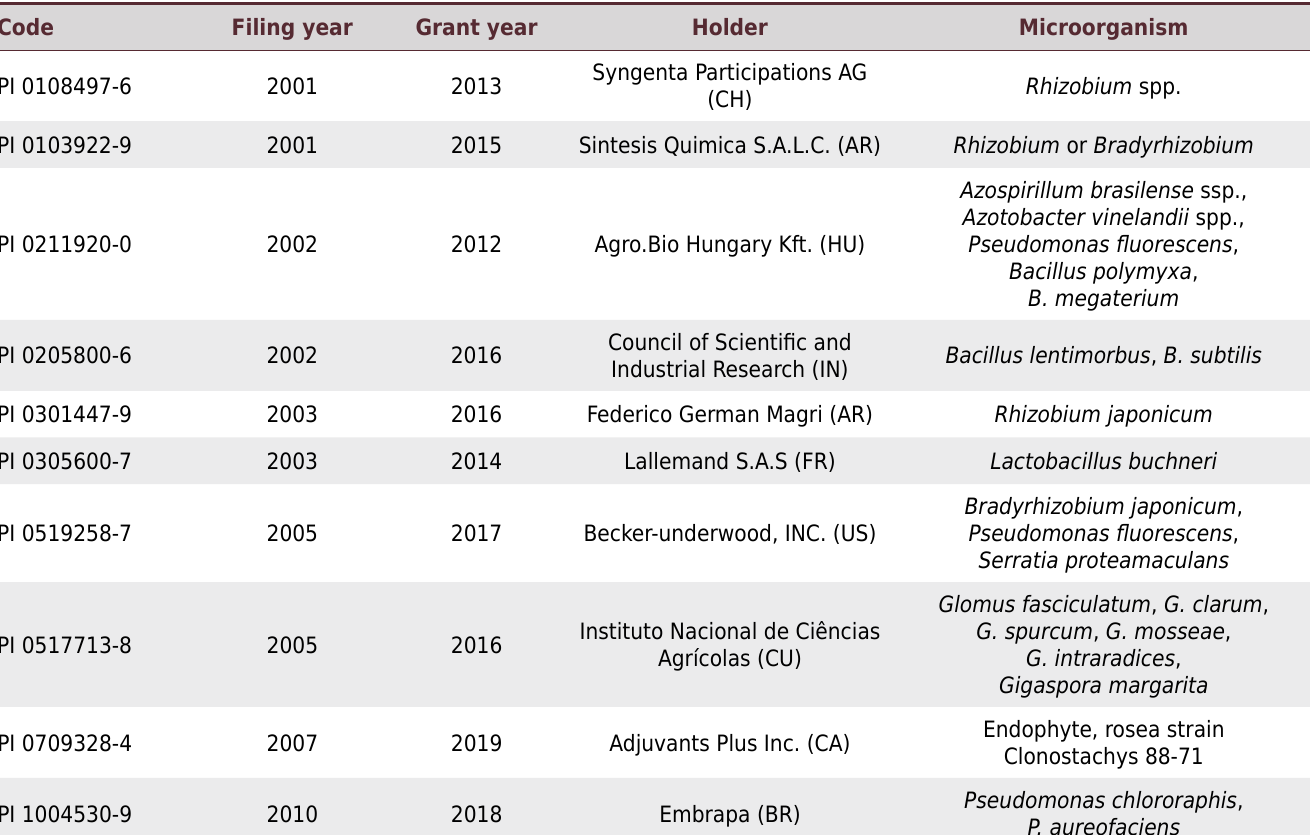
CH: China; AR: Argentina; HU: Hungary; IN: India; FR: France; US: United States; CU: Cuba; CA: Canada; BR: